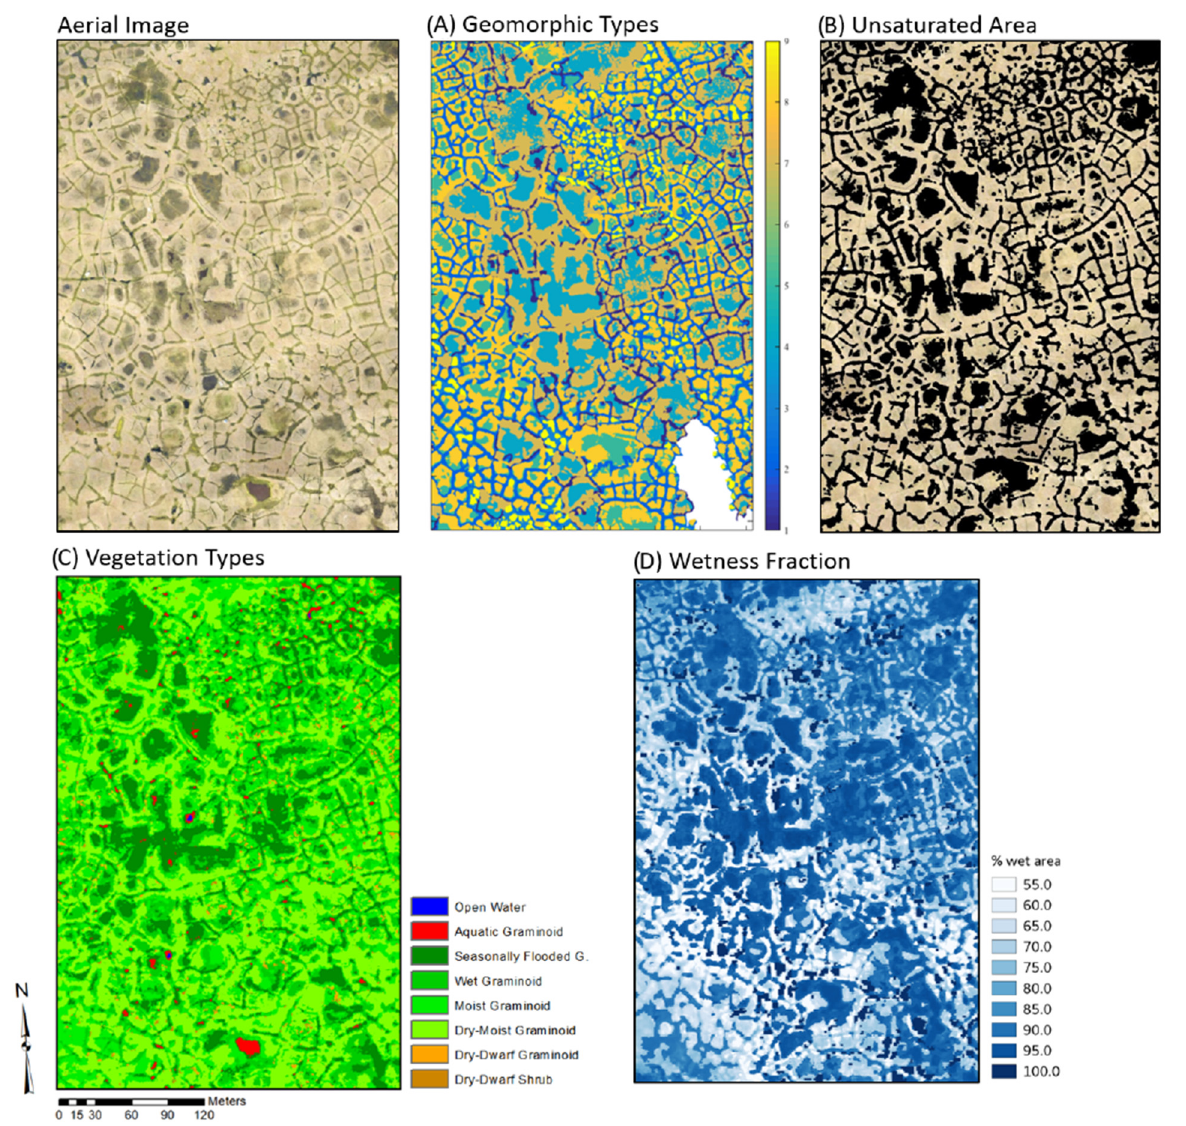
Figure 2. Study area discretized into: ( A ) geomorphic polygon types and features with a general relationship of unsaturated yellow regions and saturated blue regions, where 1 corresponds to LCP troughs (5.0% area), 2 corresponds to FCP troughs (16.1% area), 3 corresponds to HCP troughs (5.1% area), 4 corresponds to LCP centers (12.5% area), 5 corresponds to FCP centers (11.3% area), 7 corresponds to LCP rims (17.6% area), 8 corresponds to FCP rims (27.3% area), and 9 corresponds to HCP centers (5.1% area); ( B ) Color orthomosaic and its masked versions showing only unsaturated and saturated areas, respectively; ( C ) coverage of plant community type, where certain species are limited to saturated soils; and ( D ) a combination of topographic and vegetative remote observations identifying wetness fractions, where darker blues correspond to more saturated areas. See Appendix A for additional details on geospatial approaches.